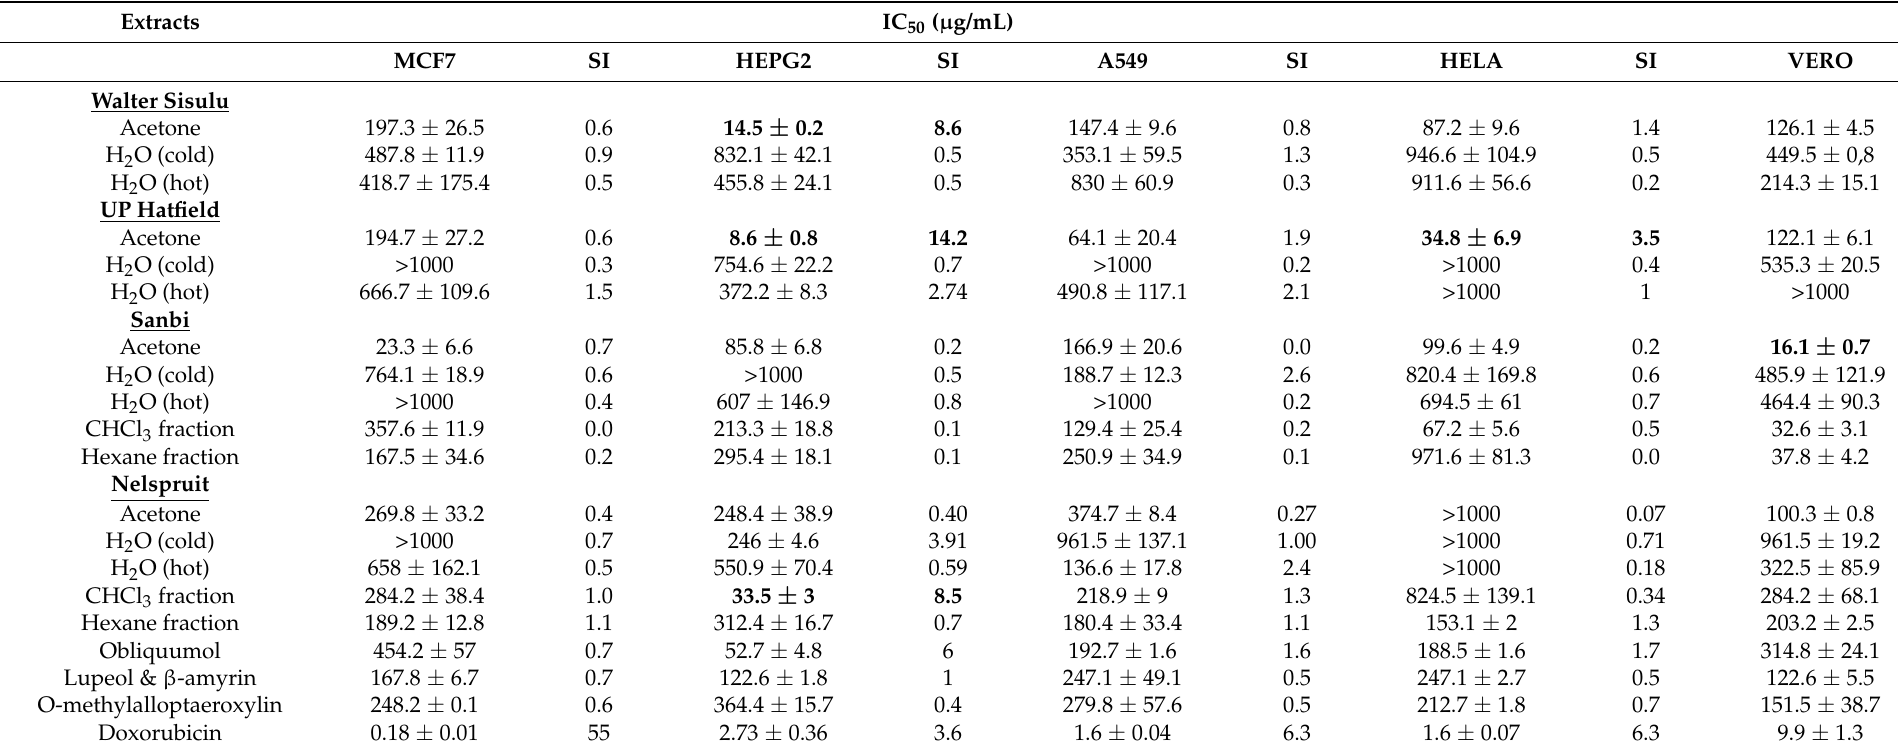
Table 1. Cytotoxicity (IC 50 in µ g/mL) and selectivity index (SI) of the extracts, fractions, and isolated compounds from P. obliquum